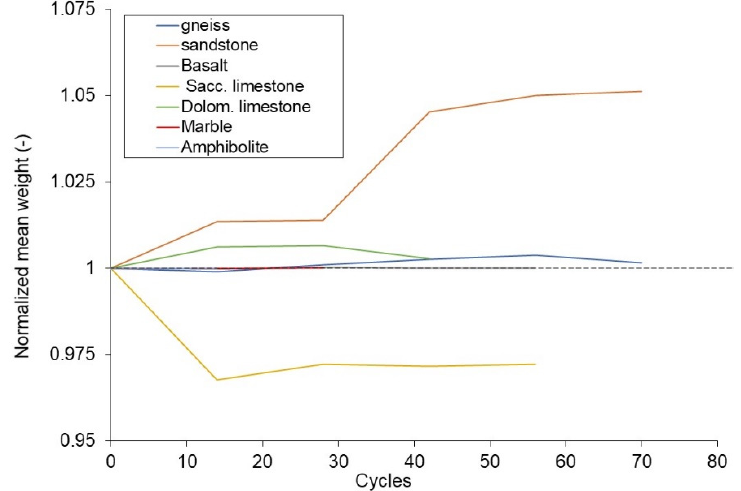
Figure 4. Evolution of the normalized mean weight of the samples. Values are normalized by the initial mean—the dot line corresponds to constant weight. Amphibolite and marble do not vary, their curves are hidden by basalt.